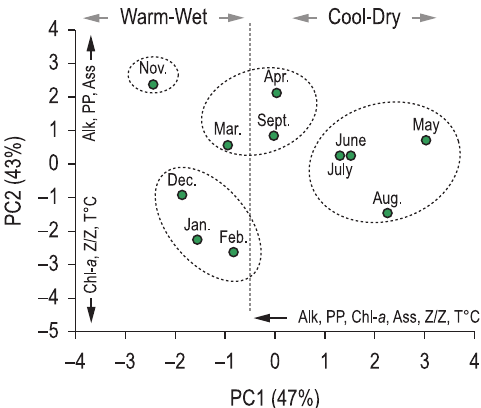
Figure 7. Spatial distribution of the cases’ loadings for the principal component (PC) analysis. Z/Z –